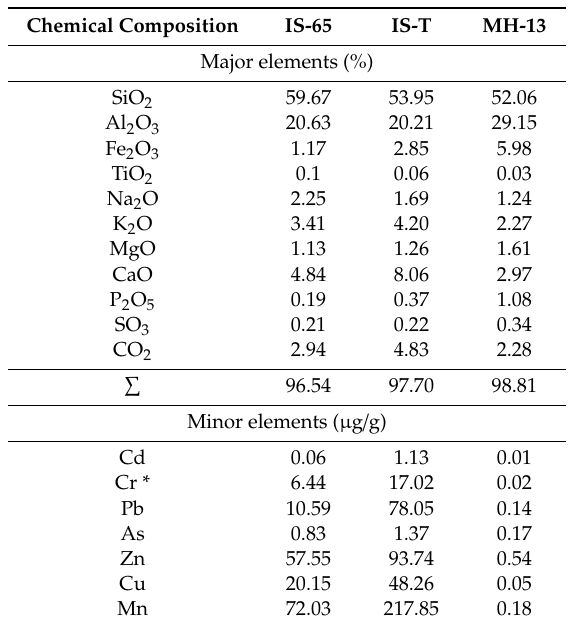
Table 3. Elemental composition of soil